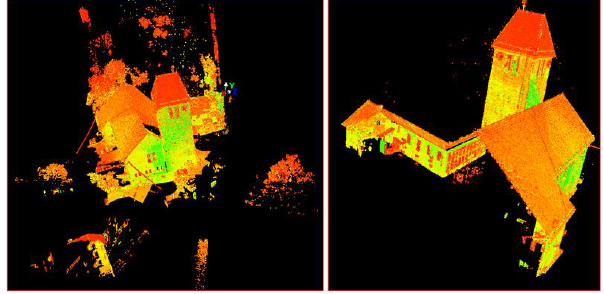
Figure 4. Point Cloud Cleaning Operations (Source: Mumtaz, 2008)